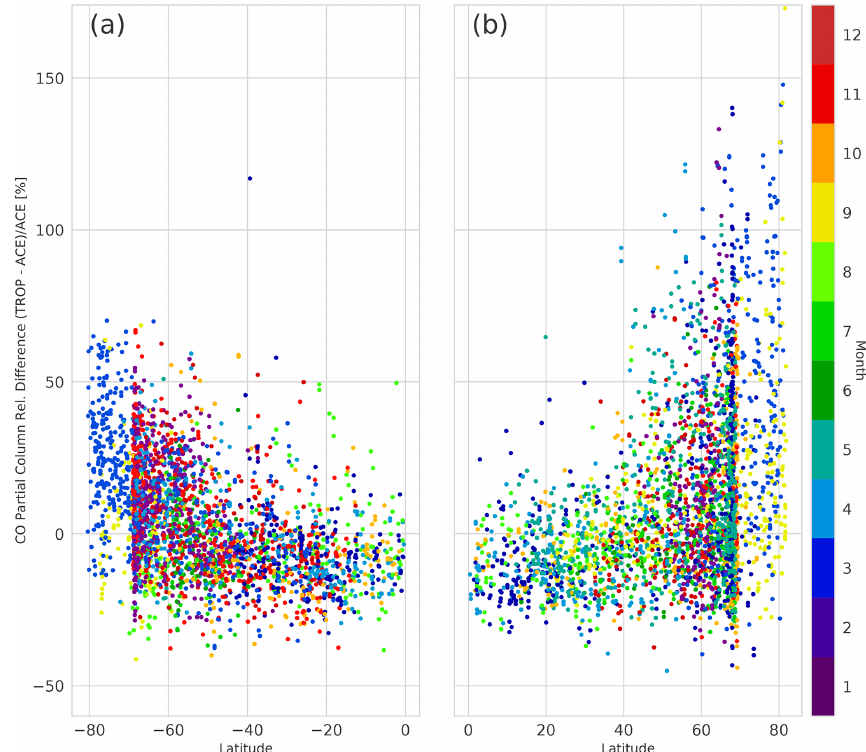
Figure 4. Relative difference between TROPOMI and ACE-FTS versus latitude in (a) the Southern Hemisphere and (b) the Northern Hemisphere for the period from 28 November 2017 to 31 May 2020. The data points are binned by colour depending on the month in which the collocation